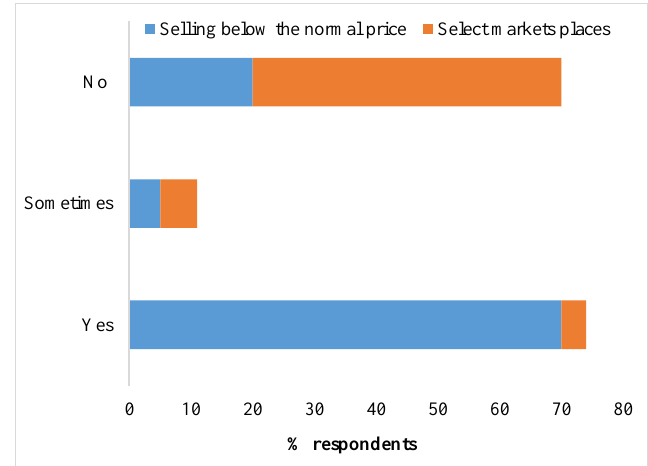
Figure 1. Summary of the horticultural produce sales during the lockdown, expressed as the percentage of respondents (n=300).